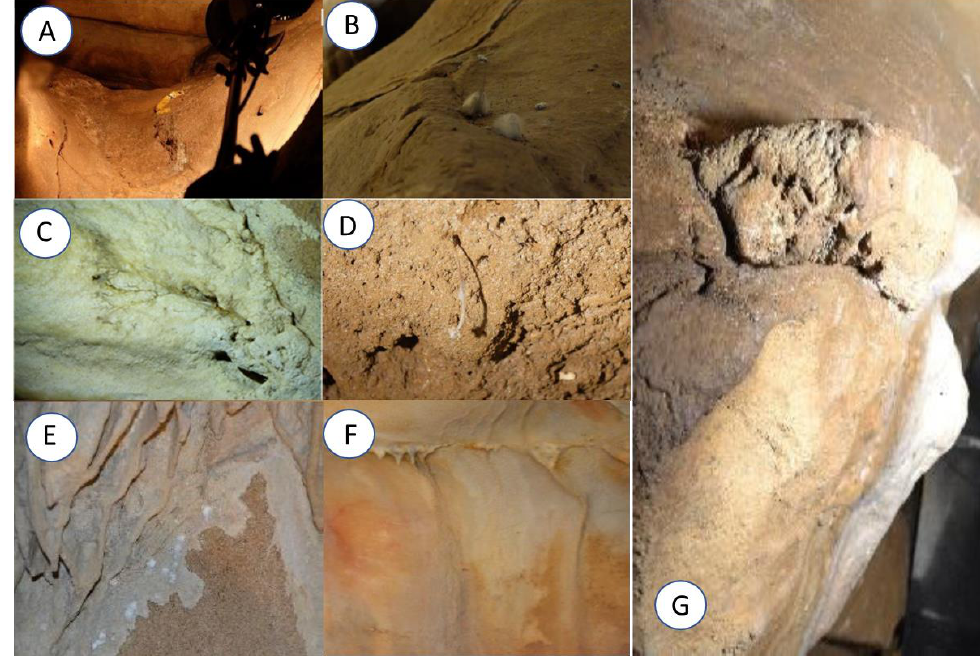
Figure 1. In situ observations of biological and microbial contaminations in the Escoural Cave. ( A ) Macrofungi growth covered by other microbial communities. ( B ) Widespread fungal growths on the walls of the cave. ( C ) Roots and sap developing on the ceiling of the cave. ( D ) Root coming out of soil covering the walls of the cave. ( E ) Microbial colonies. ( F ) Effect of precipitation, with pigmentation and the buildup of calcite crusts. ( G ) Biological colonization and moonmilk